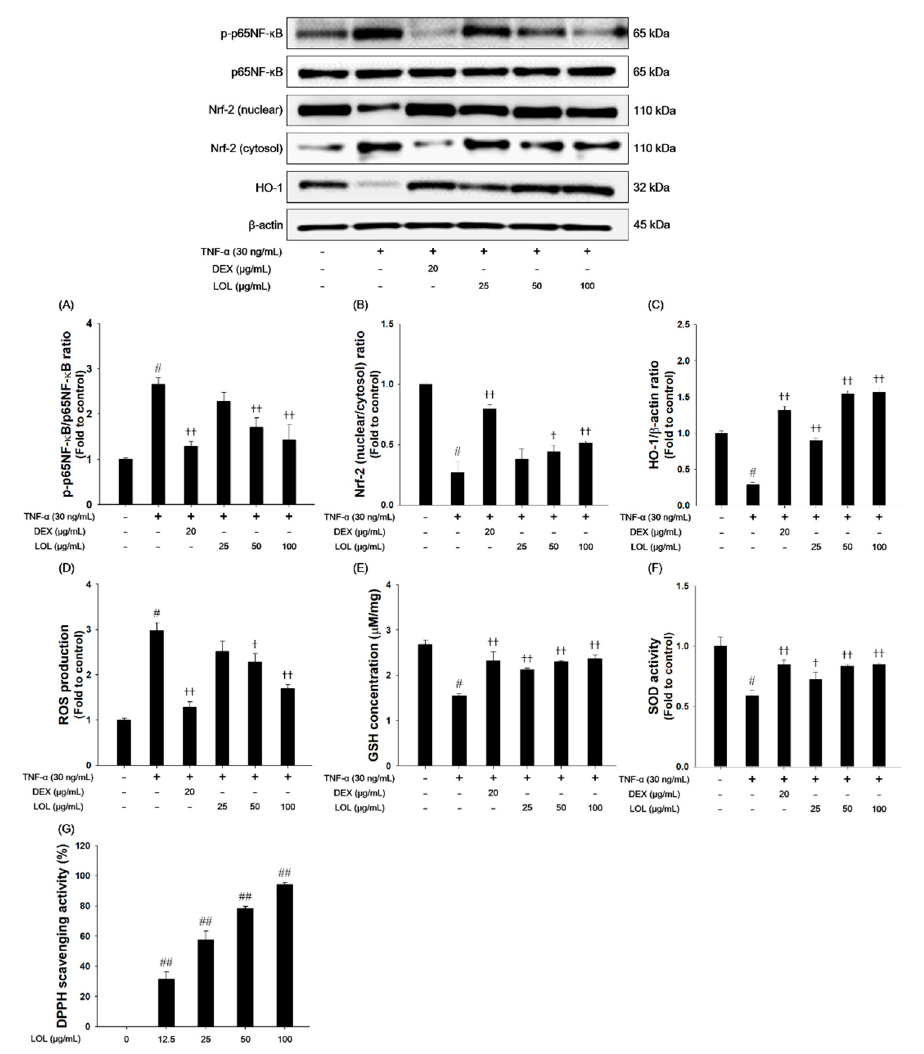
Figure 8. E ff ects of LOL on p65NF- κ B, Nrf-2, HO-1 and oxidative stress makers in TNF- α -stimulated NCI-H292 cells. The ( A ) p-p65NF- κ B, ( B ) Nrf-2 and ( C ) HO-1 were analyzed by western blot ( β -actin: loading control). The levels of ( D ) ROS and ( E ) GSH, and activities of ( F ) SOD were determined in TNF- α -stimulated NCI-H292 cells. The cells treated with LOL (25, 50 and 100 µ g / mL) and DEX (20 µ g / mL) for 1 h and incubated with TNF- α (30 ng / mL) for 30 min (p-p65NF- κ B, Nrf-2, HO-1, GSH and SOD) or 24 h (ROS production). ( G ) The DPPH radical scavenging activity was evaluated by DPPH assay. Each value represents the means ± SD ( n = 3). # p < 0.01 and ## p < 0.001, significantly di ff erent from control; † p < 0.05, †† p < 0.01, significantly di ff erent from TNF- α -treated group.